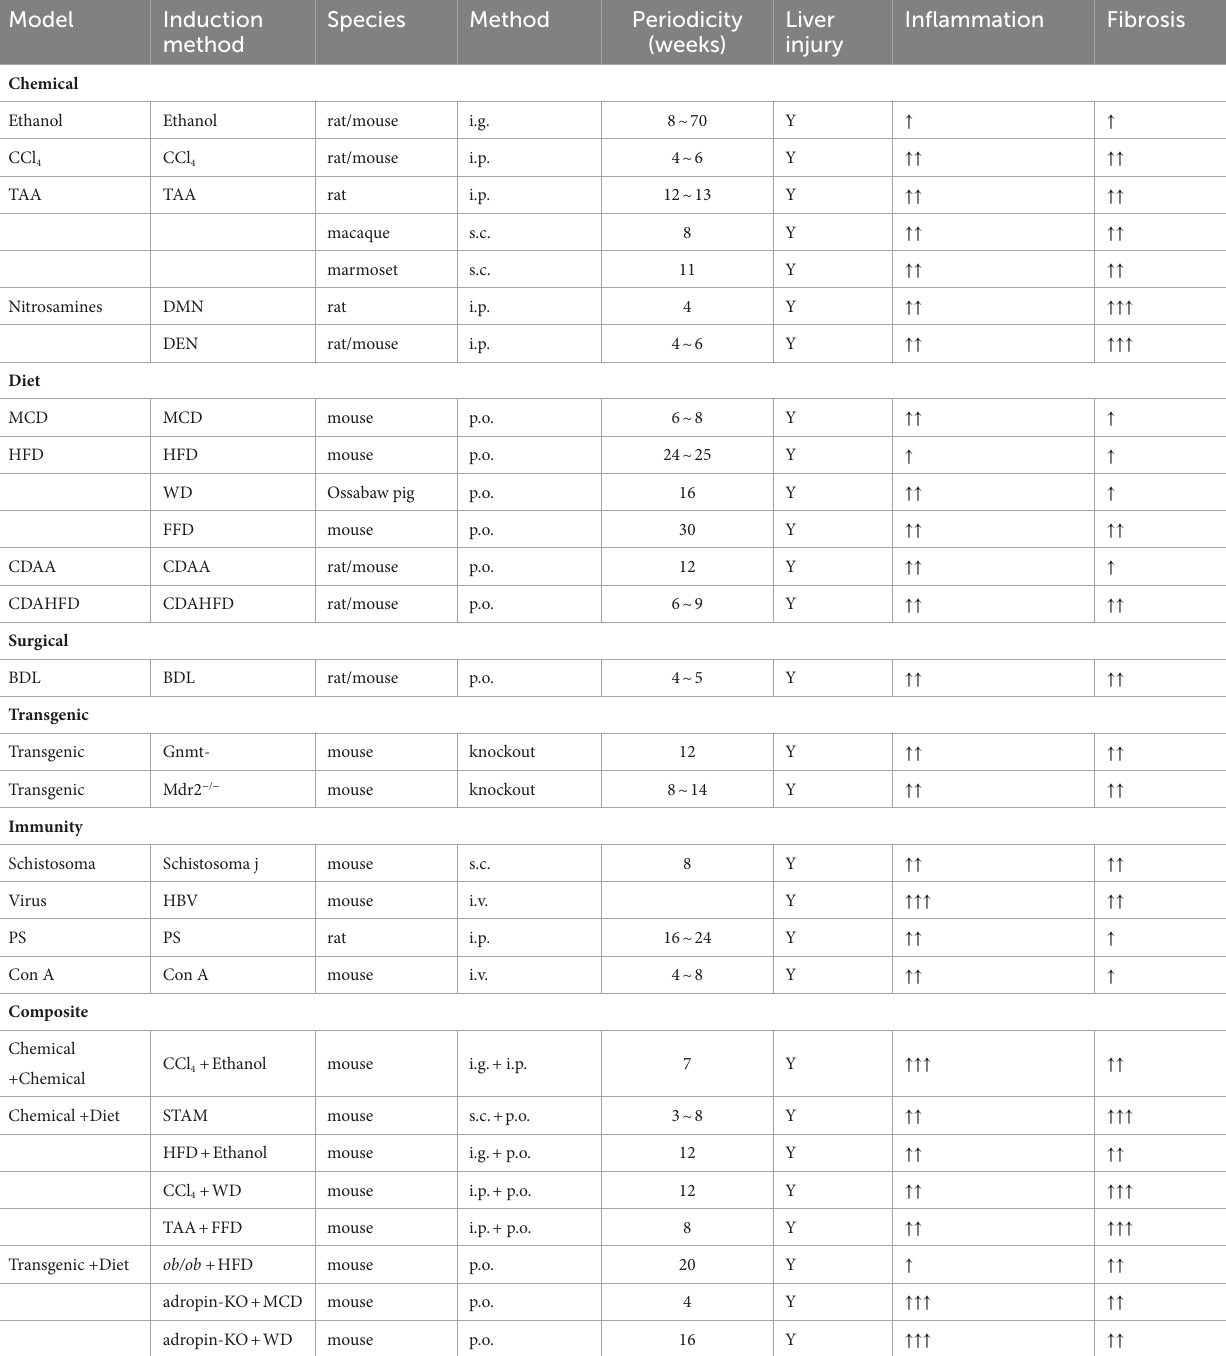
TABLE 1 Induction method, modeling time, and liver fibrosis in animal models of liver